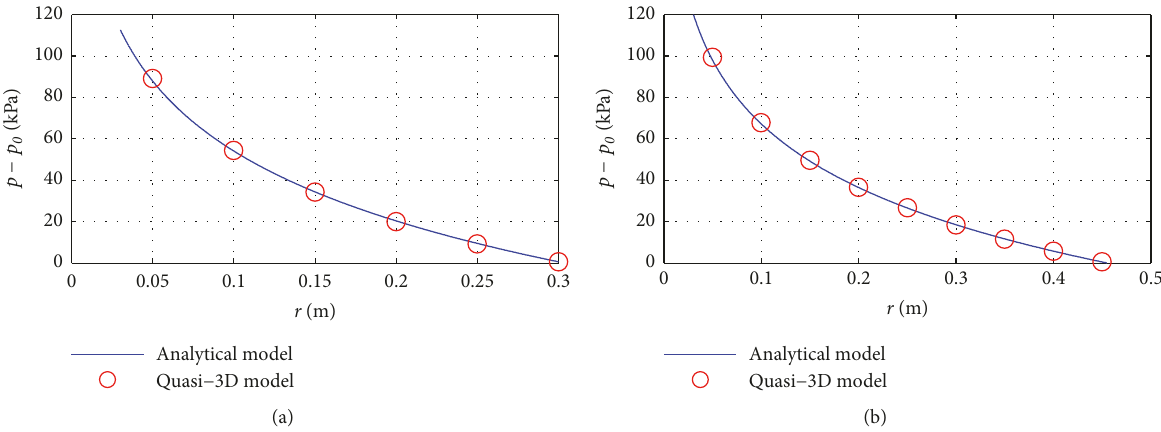
Figure 14: Pressure distribution over radius at different times in Case 2 (a) t = 20 s; (b) t = 50 s.